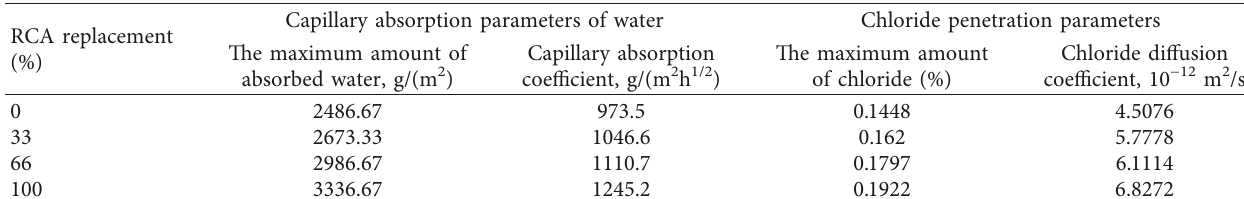
Figure 4: Mechanism of water penetration into RAC under the force of capillary absorption. Table 4: Parameters of capillary water absorption and chloride penetrations.